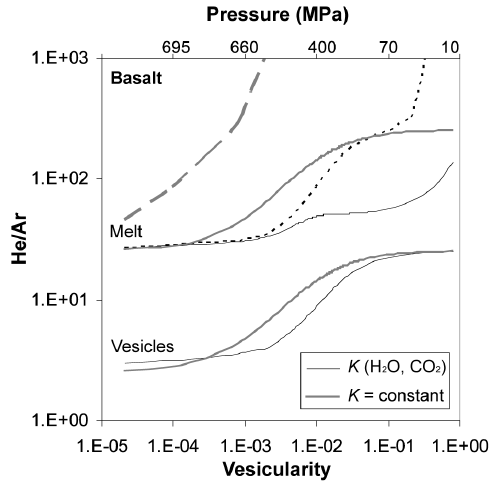
Fig. 13. He/Ar fractionation during closed system degassing of basaltic melt at 1200°C. Initial He/Ar ratio was 3. Thick grey lines were computed by us- ing the model of Jambon et al . (1986) (eq. (4.2) in the text), assuming noble gas solubilities were not af- fected by the presence of the main volatiles ( K =con- stant) and ideal gas behavior. Thin black lines were computed on the basis of the model by Nuccio and Paonita (2001), which accounts for these effects. In this model, the initial conditions were 85 mol% CO 2 in the H 2 O-CO 2 mixed vapor (noble gases are com- puted as minor species) at 700 MPa pressure. Black thin lines for melt and vesicles approach each other at low pressure, due to the effect of water that makes the solubilities of noble gases more similar. Dashed curves were computed for an open system (grey line by Jambon et al ., 1986 model black line by Nuccio and Paonita,